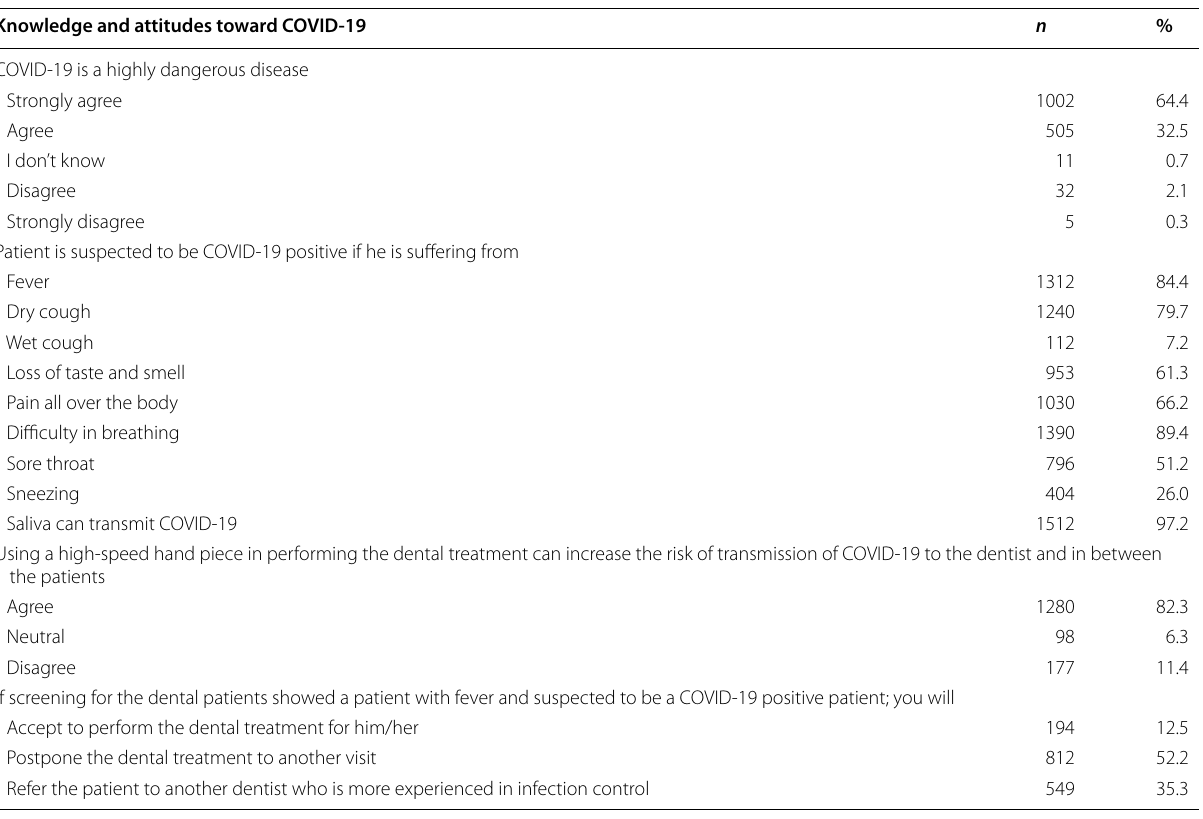
Table 1 Frequencies ( n ) and percentages (%) for responses to questions regarding knowledge and attitudes toward COVID-19 ( n 1555) =